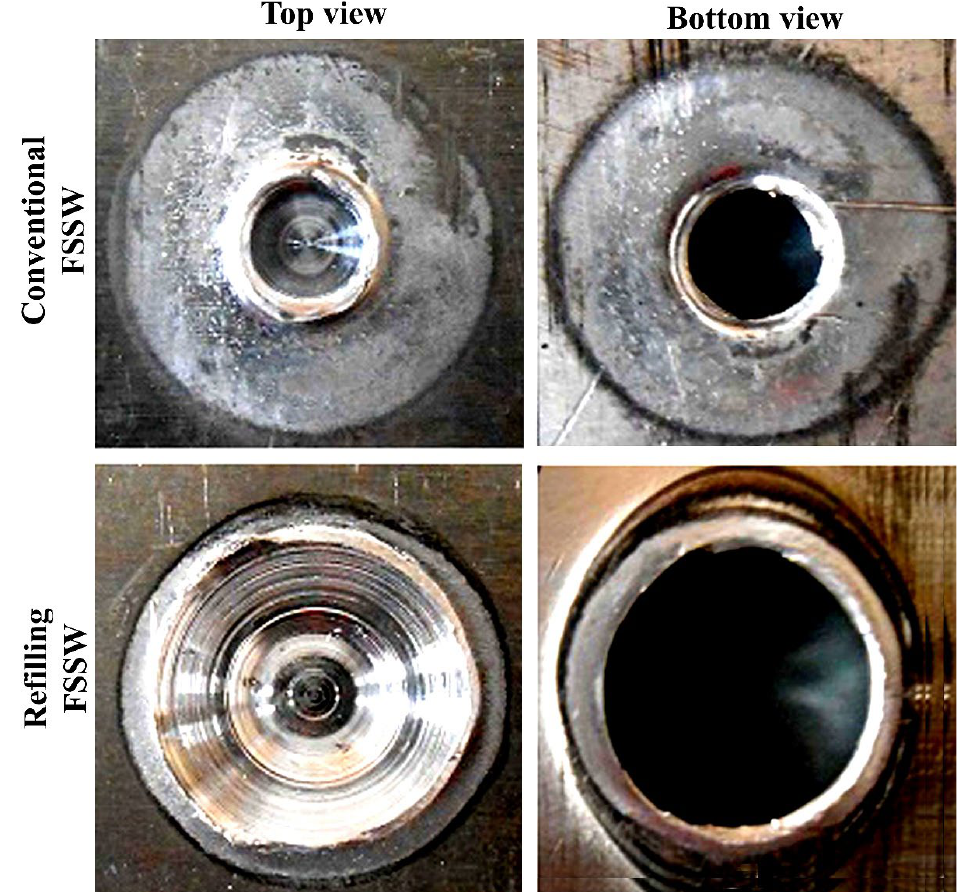
Figure 15. Macroscopic appearance of the failure modes (Dissimilar AZ31B/AA6061-T6